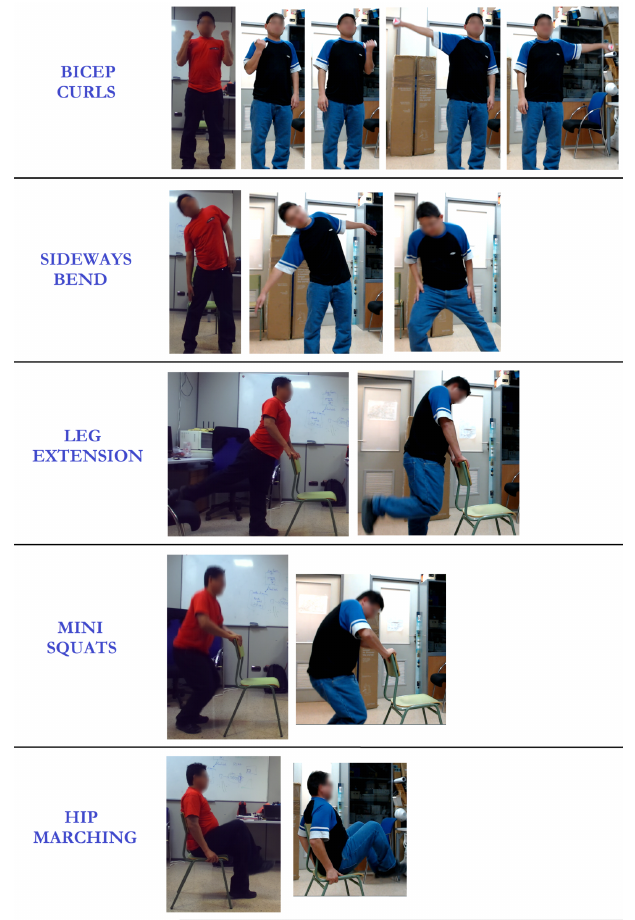
Figure 5. Samples of bad performances for some considered exercises such that the first column indicates the physical exercise to be done; the second column represents the expected pose and the rest of columns illustrate some bad performances of that